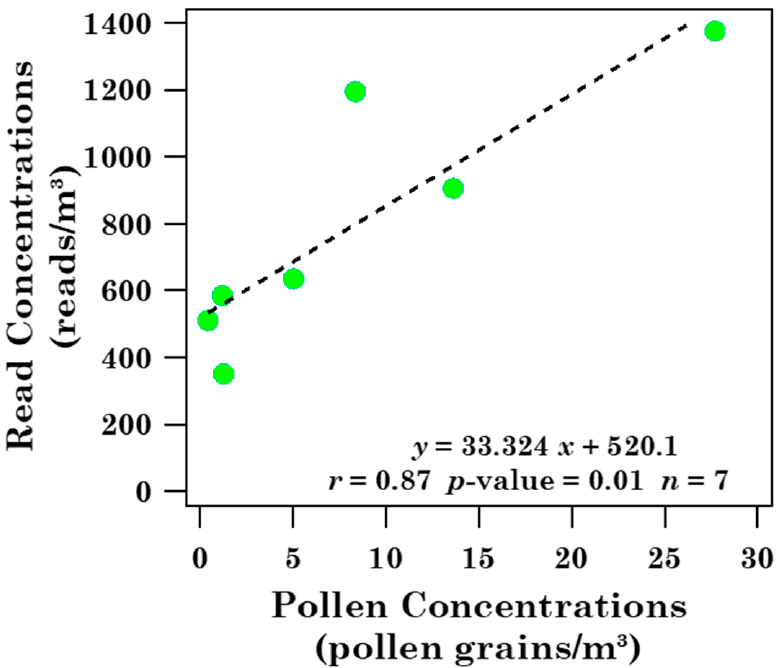
Figure 10. Read concentration as a function of the corresponding pollen grain concentration of the common pollen families detected both in Brindisi and in Lecce in spring. Fitting regression line equation, Pearson correlation coefficient ( r ), p -value, and the number of points ( n ) are also given.